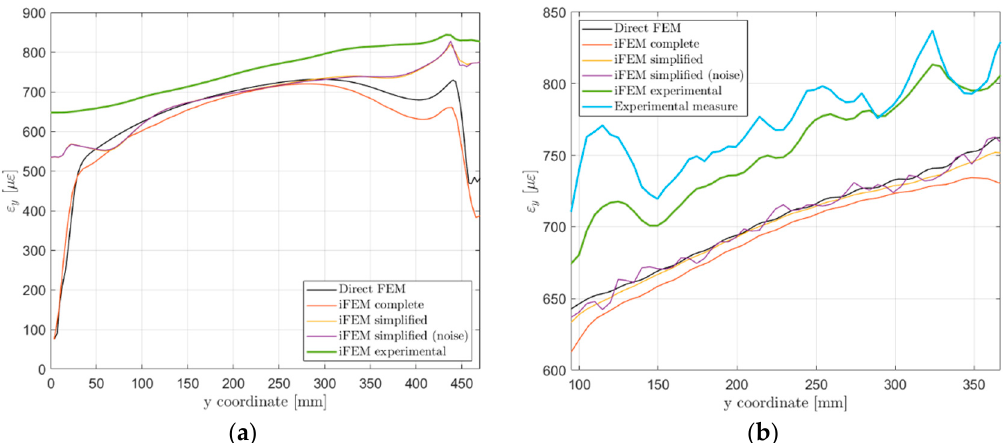
Figure 17. Simplified iFEM model results with experimental input strain measurements, deformed shape with scale factor 100: ( a ) Displacement field on the x-direction, ( b ) displacement field on the y-direction, ( c ) displacement field on the z- direction, ( d ) strain field on the y-direction on the top side of the structure.